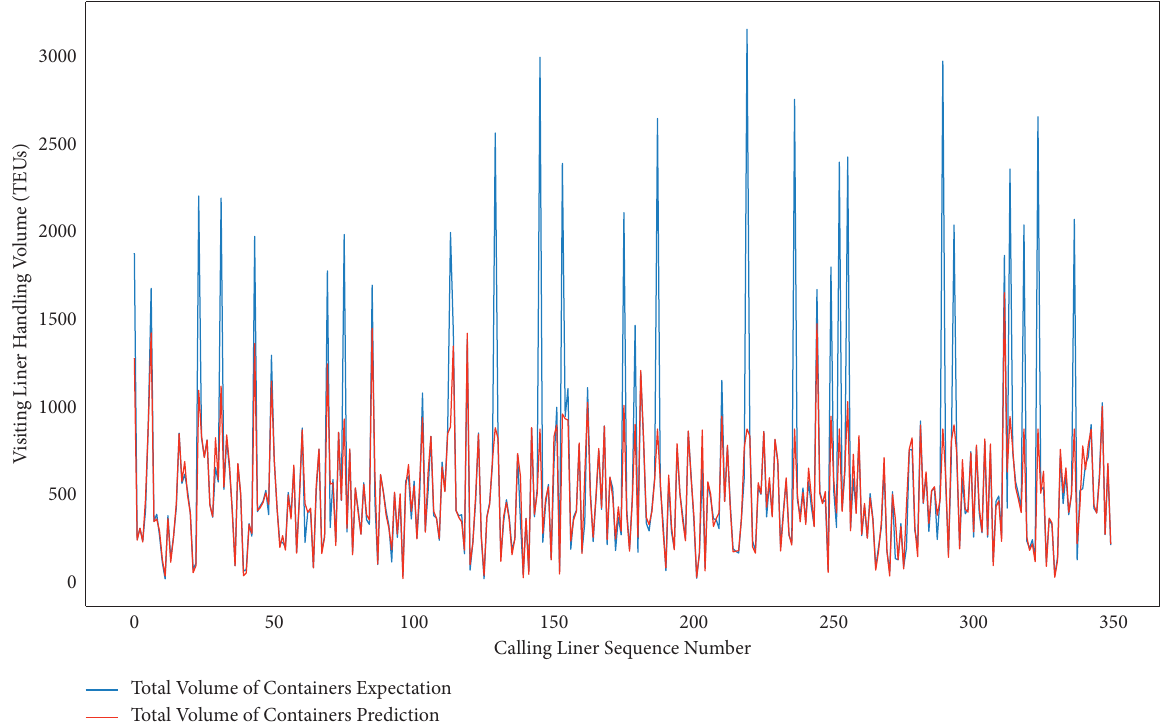
Figure 4: A comparison of LHV predicted and true values by the Gaussian SVM